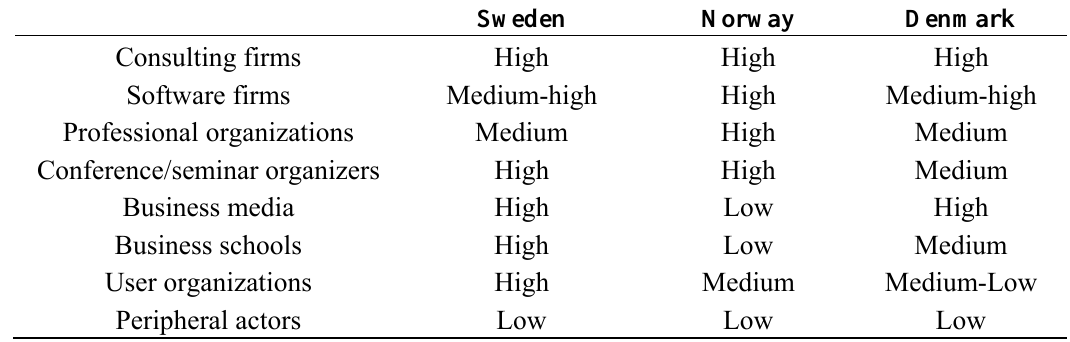
Table 4 . The relative importance of the various actors 1992–2011 (source: [30] (p.